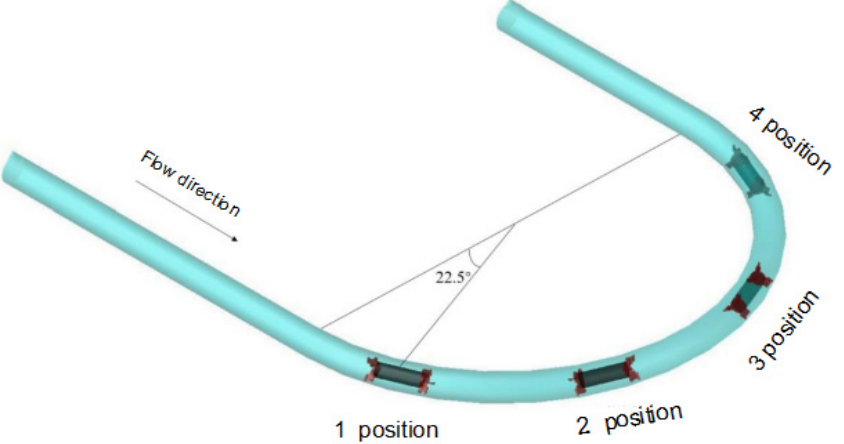
Figure 3. Schematic diagram of capsule at different positions of elbow.